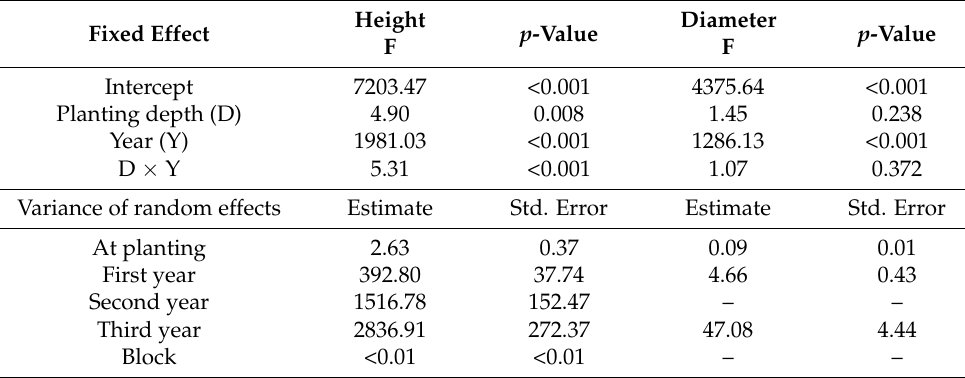
Figure 2. Height ( a ) and diameter ( b ) development in silver birch seedlings in 2016–2018 at planting depths of 3, 6 and 8 cm (length of belowground shoot). The height and diameter of the seedlings were measured at the time of planting, after the first, second (height only) and third growing seasons. Vertical bars indicate the standard error of the means ( n = 73–80). The different letters indicate statistically significant ( p < 0.05) differences among planting depths within each year. Table 1. Repeated (year Y) linear mixed model analysis for the effects of planting depth (D) on the height and diameter of silver birch seedlings. The variance of random effects of each planting year and block are also